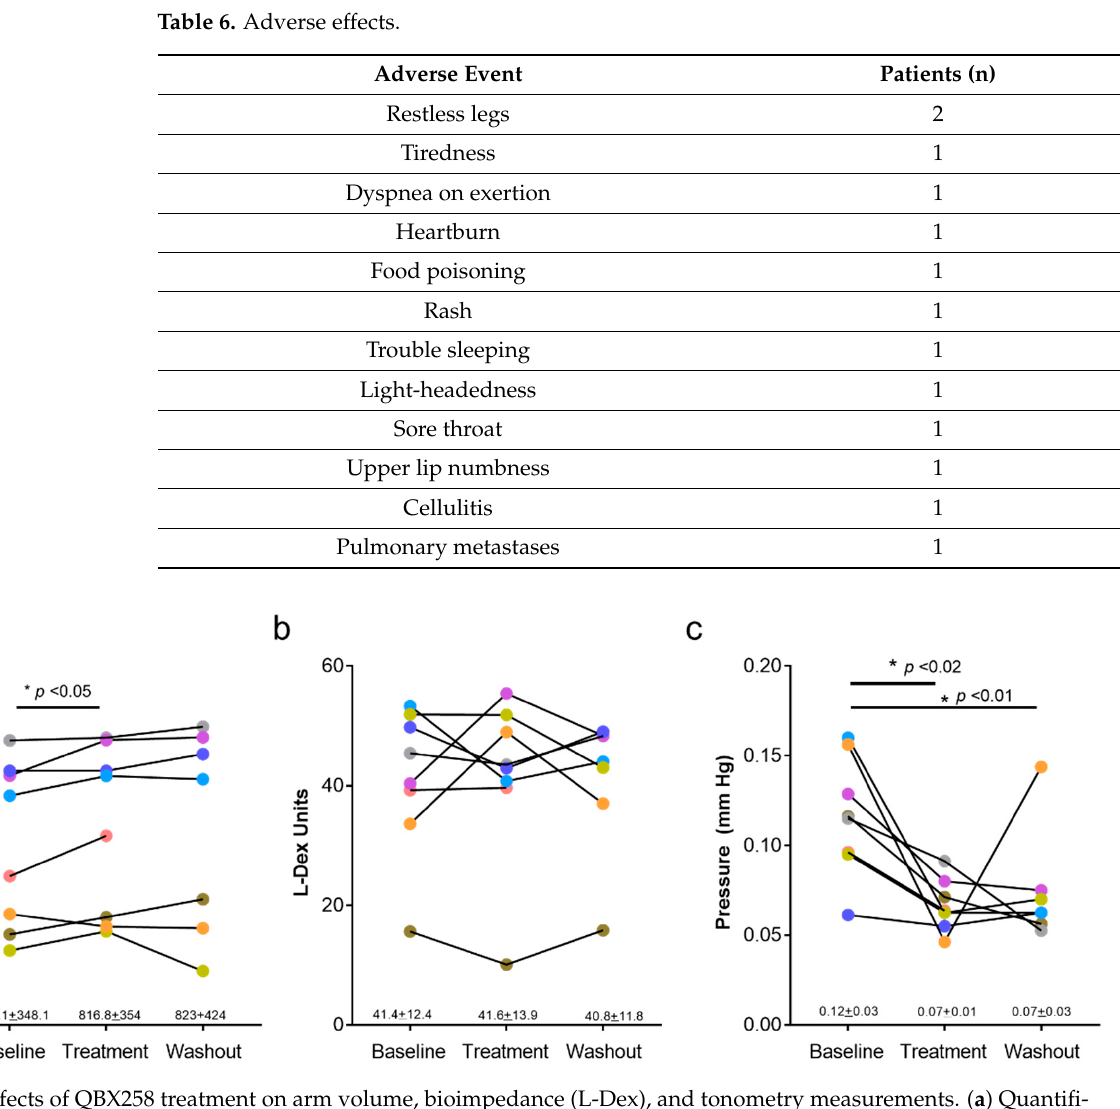
Table 6. Adverse effects.